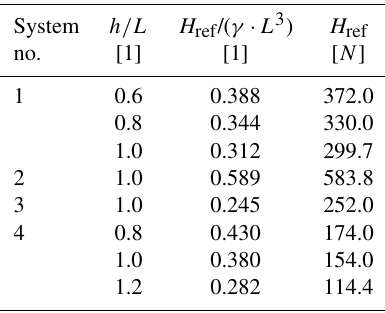
Table 5. Pile reference loads ( H ref ) determined by extrapolation of test